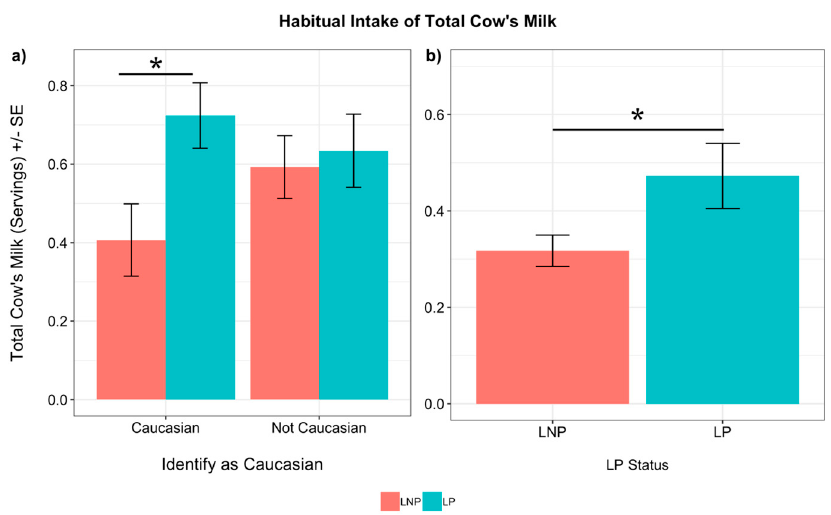
Figure 3. Reported habitual intake of total cow’s milk via the FFQ: ( a ) Unadjusted mean servings for lactase persistent (LP) and lactase non-persistent (LNP) subjects stratified by whether subjects identified as Caucasian ( n = 126) or not (African-American, Asian, and Hispanic subjects; n = 72) and ( b ) Adjusted mean servings for LP ( n = 114) and LNP individuals ( n = 84), adjusted for whether subjects were Caucasian or not Caucasian. Habitual cow’s milk was not associated with the LP genotype unless tested in combination with the Caucasian ethnicity. p values were calculated from linear models using log -transformed values. Significant di ff erences are denoted by asterisks (* p < 0.05). Error bars indicate standard error.